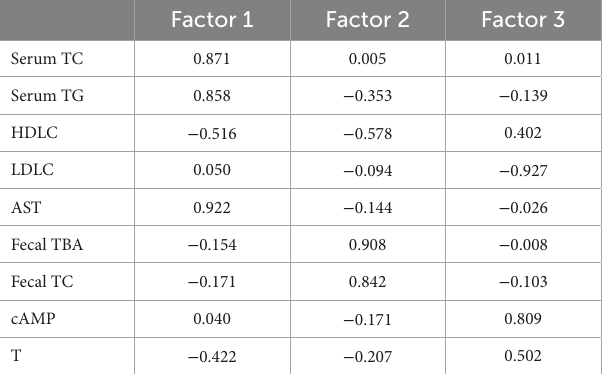
TABLE 3 Rotated component matrix of factor 1, factor 2, and factor